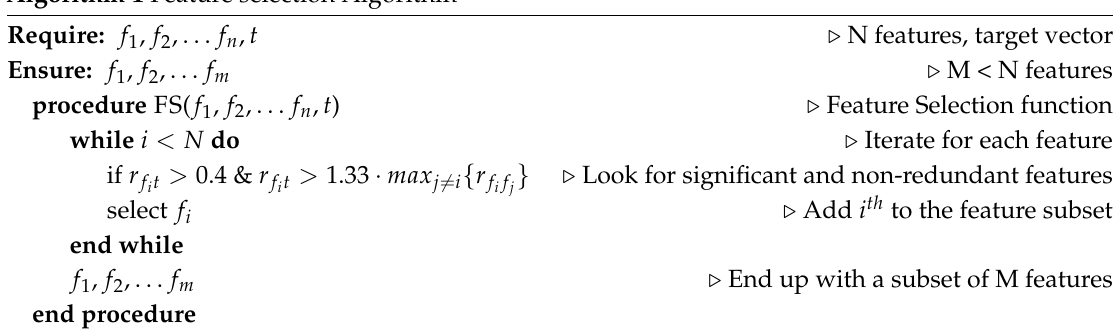
Algorithm 1 Feature selection Algorithm